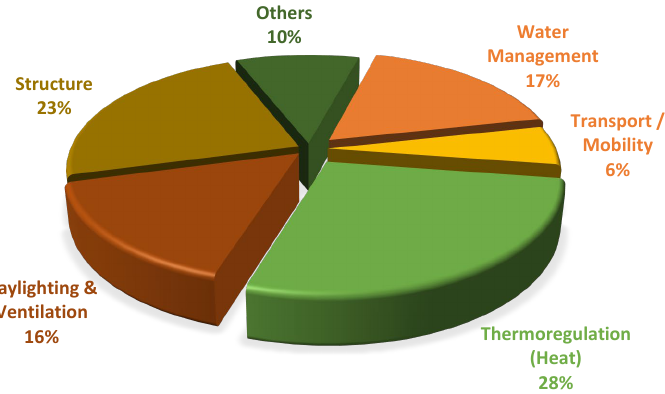
Figure 1. The frequency of student biomimicry projects classified by themes (n = 69).